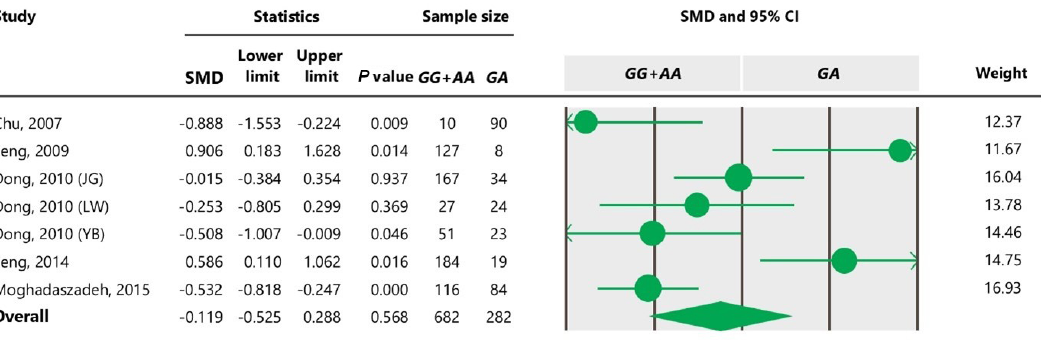
Table 7. Forest plot of association between c.963A > G polymorphism and litter size under the co-dominant model. For additional details refer to the Table 4 caption.